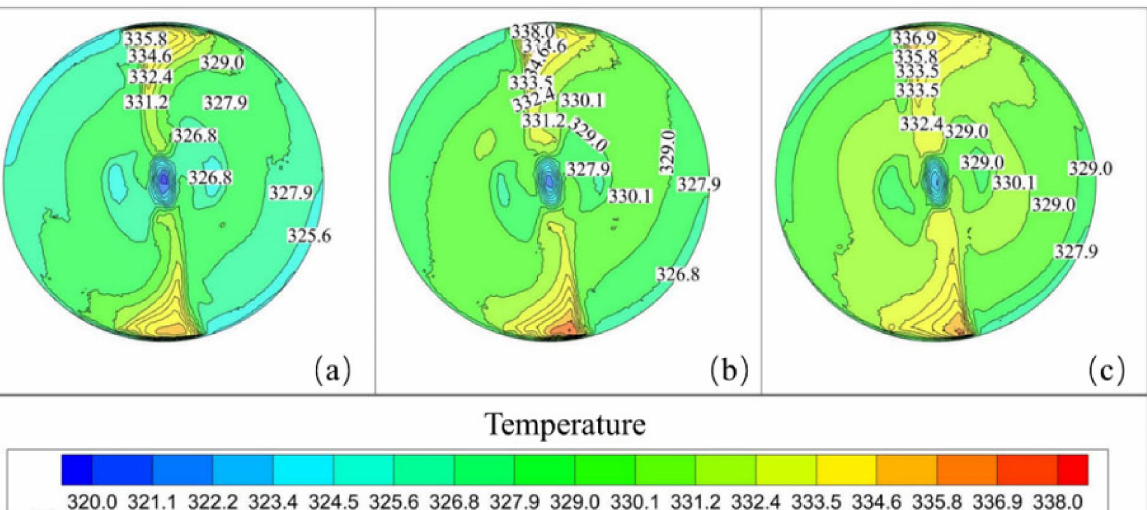
Figure 16. Effect of different spacings on temperature distribution: ( a ) 0.097 mm; ( b ) 0.24 mm; ( c ) 0.32